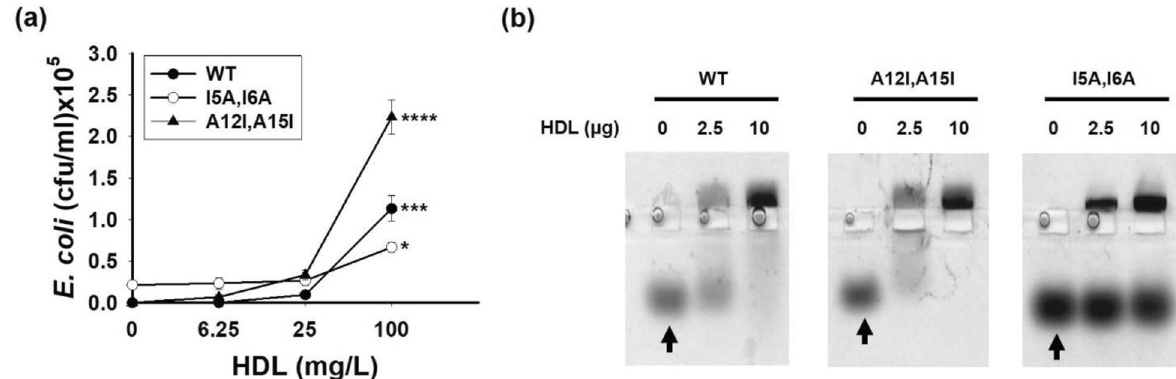
Figure 4. Hydrophobic residues of TP4 were responsible for its binding to HDL ( a ) Effect of HDL on the antimicrobial activities of TP4-WT, TP4-I5A,I6A and TP4-A12I,A15I (40 mg/L each) to E. coli (10 7 cfu/ml). Values are the mean ± SD (n = 3). Kruskal–Wallis tests were performed to determine the significance of the difference in each group. * Indicates P ≤ 0.05, *** Indicates P ≤ 0.0005, **** Indicates P ≤ 0.00005. ( b ) Band shift of TP4 variants (4 µg) by HDL and analyzed by 8% horizontal native PAGE and Coomassie blue staining. Arrow indicates control (non-shift)